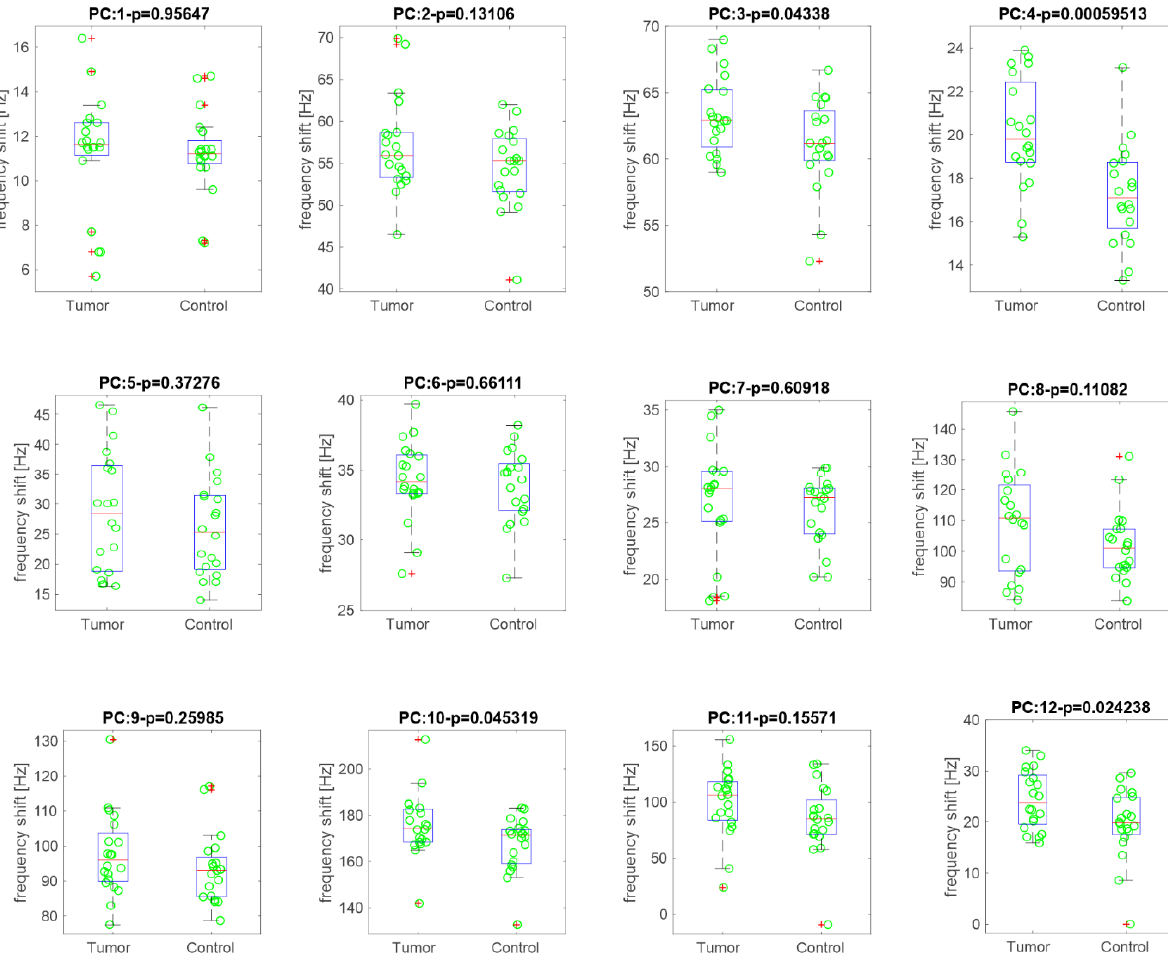
Figure 8. Box plots of sensor’s responses respect to cancer and control groups. A better appraisal of the diagnostic properties of volatile compounds as detected by GC/MS and sensor arrays are achieved by classification algorithms. Linear Discriminant Analysis (LDA) was applied to GC/MS and sensors array data. The datasets have been split in two parts, one used to train the model and the other to test. A random split of data in two groups may result in favorable conditions that could lead to optimistic conclusions. To avoid this drawback, LDA has been calculated 100 times, each time with a different partition of data in training and test. Accuracy, namely the percentage of correct classifi- cation of test data, has been considered as the indicator of the goodness of the model. Eventually, the LDA model corresponding to the average accuracy was retained as repre- sentative for the classification. Figure 9 shows the canonical variables and the area under the ROC of both GC/MS and sensor array classification models while the results of classification are listed in Table 4.